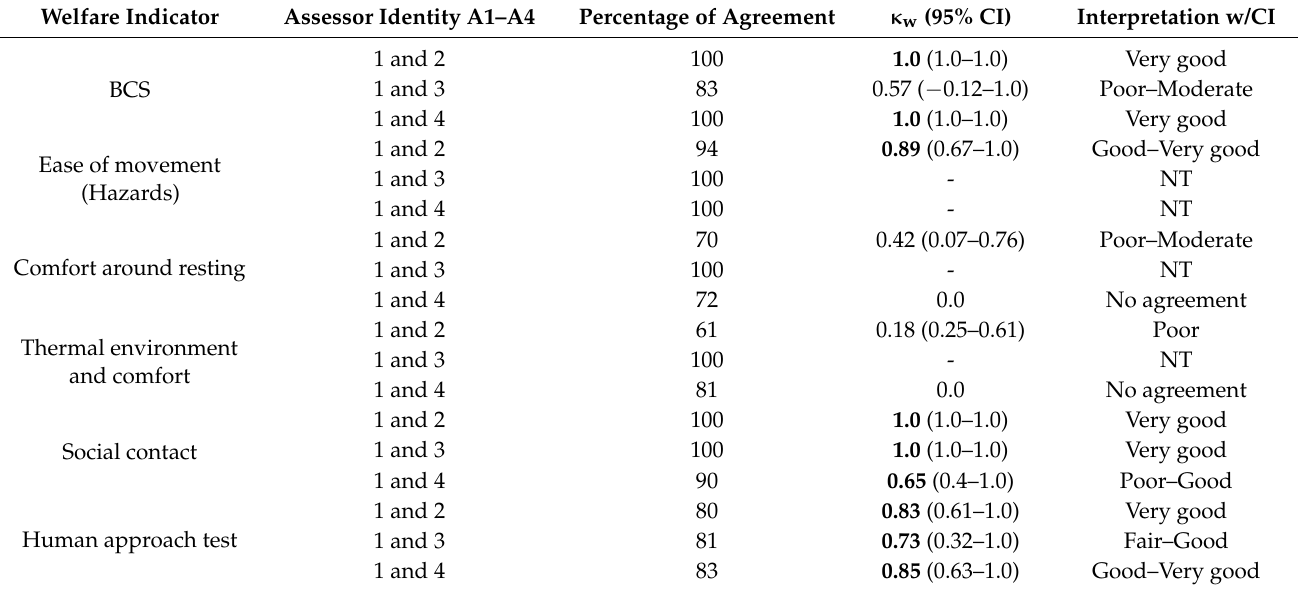
Table 3. κ w estimates and their 95% confidence intervals for welfare indicators in the prototype assessment, which were tested for inter-assessor reliability between the primary investigator and each of the assessors. Assessor 1 (A1) (primary investigator) assessed all thirty-five ponies along with one of the other assessors (A2–A4). NT—data were not able to be tested due to an insufficient number of categories. All values of 0.61 (good) and above are shown in bold. κ w is 1 when there was perfect agreement and 0 when there was no agreement better than chance. Interpretation is according to the work of Altman [54].